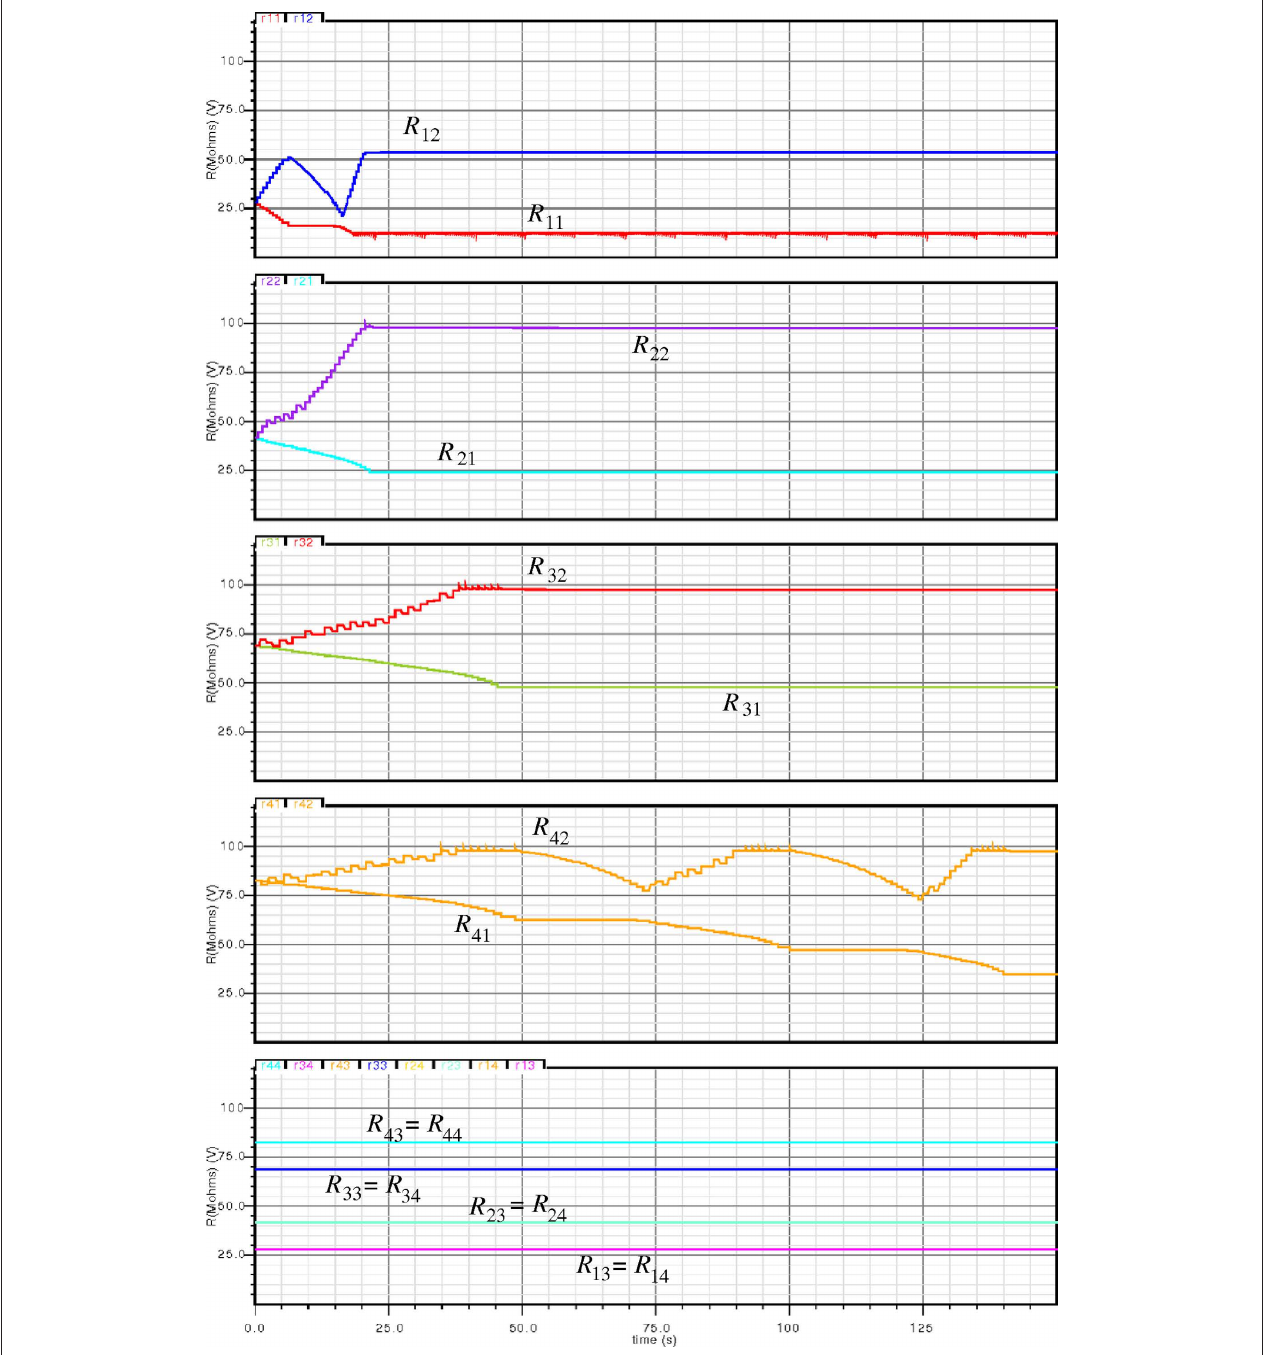
Figure 13 | evolution of weights (resistances) in a 4 × 4 feed forward memristive perceptron network. The bottom trace shows the weights of memristors in the third and fourth column. The other traces show the evolution of weights in the two columns furthest to the left. Traces are grouped pair-wise with synapses in the same row, and with identical initial